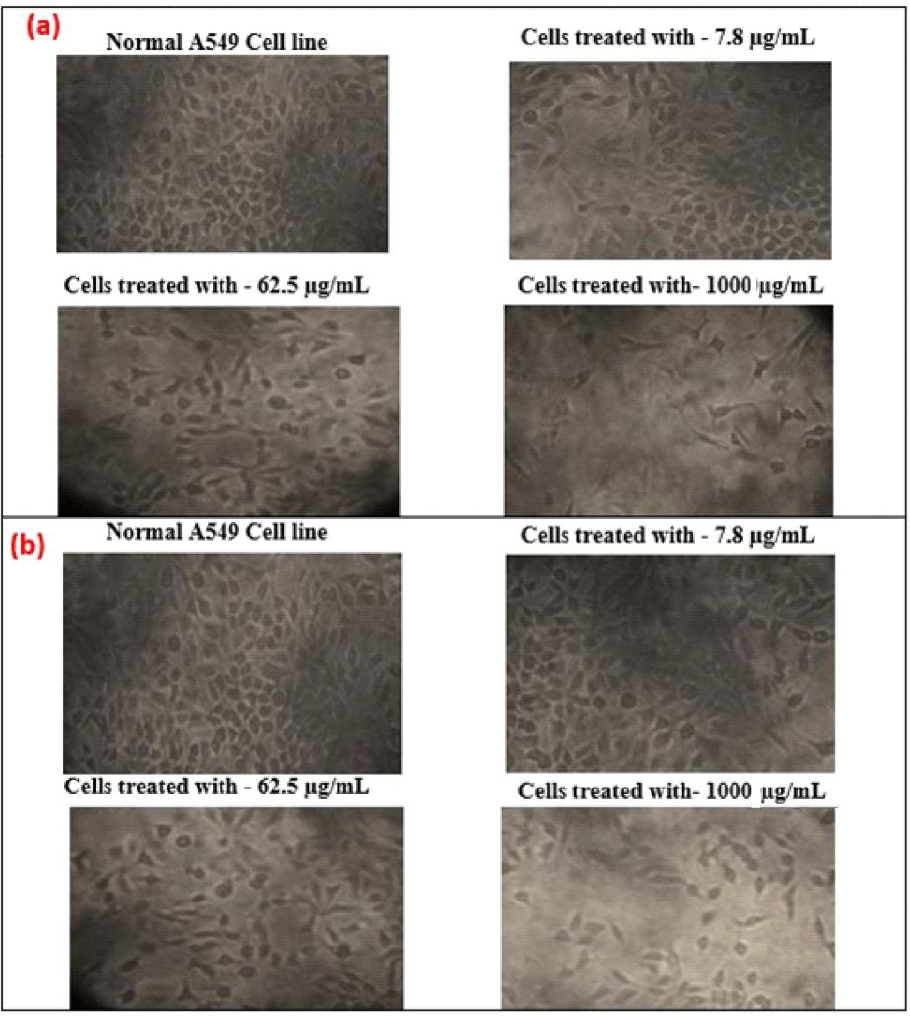
Figure 12. ( a ) Anticancer effect of GO on A549 human lung cancer cells; ( b ) anticancer effect of T-rGO on A549 human lung cancer cells.